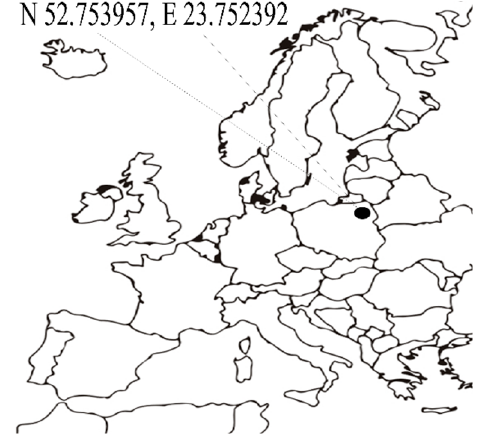
Figure 1. Location of the study.